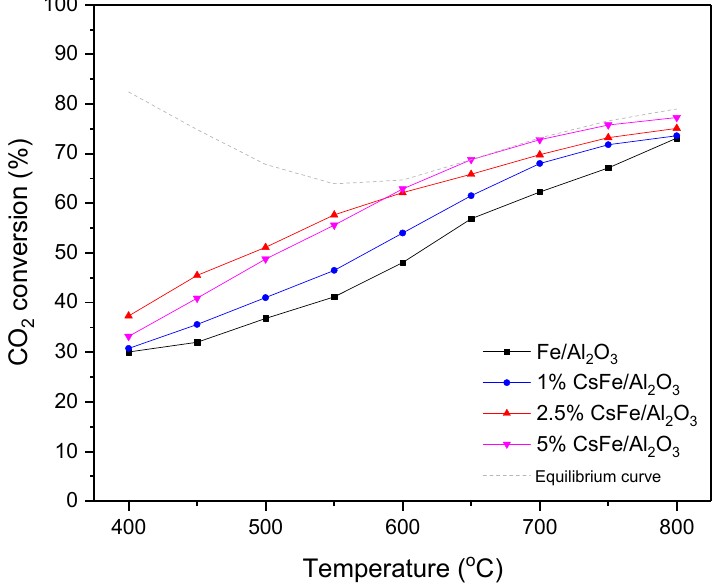
◦ C, WHSV of 12,000 mL/g cat h, and H 2 /CO 2 ratio of